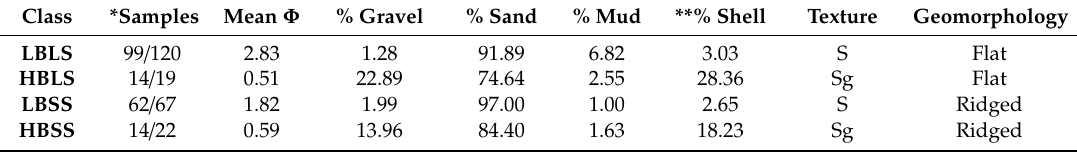
Table 2. Table showing mean grain-size statistics for each class. *Sediment samples in column two are reported as a ratio of sample agreement with mean texture. For example, for the low backscatter areas with low slopes (LBLS) class, 99 out of 120 samples were classified as ‘S’ based on [66], leaving